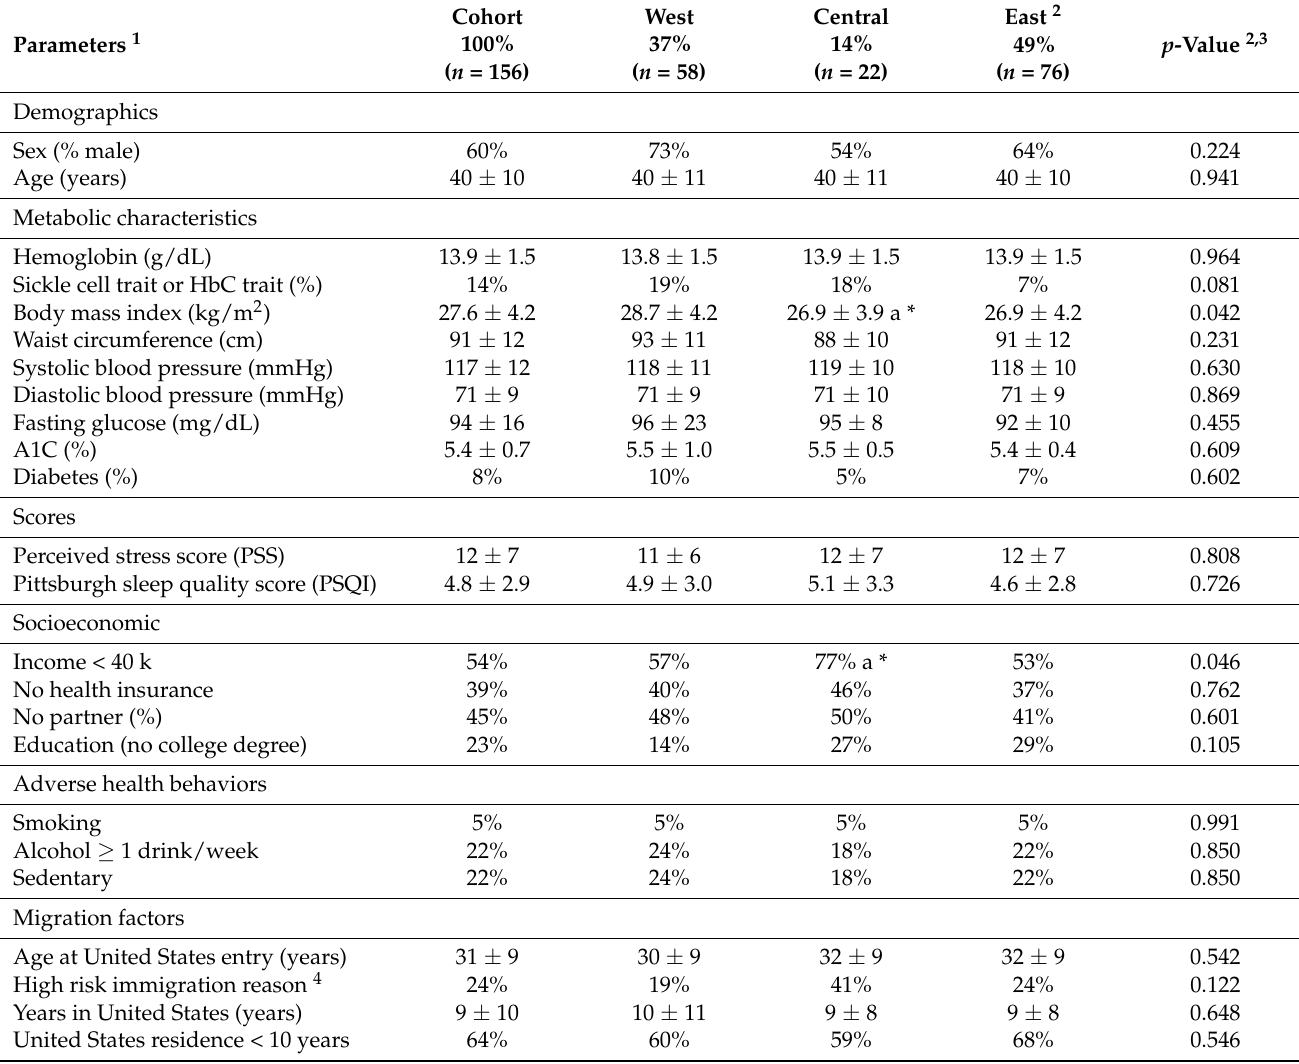
Table 1. Demographic, Metabolic and Social Characteristics by African Region of